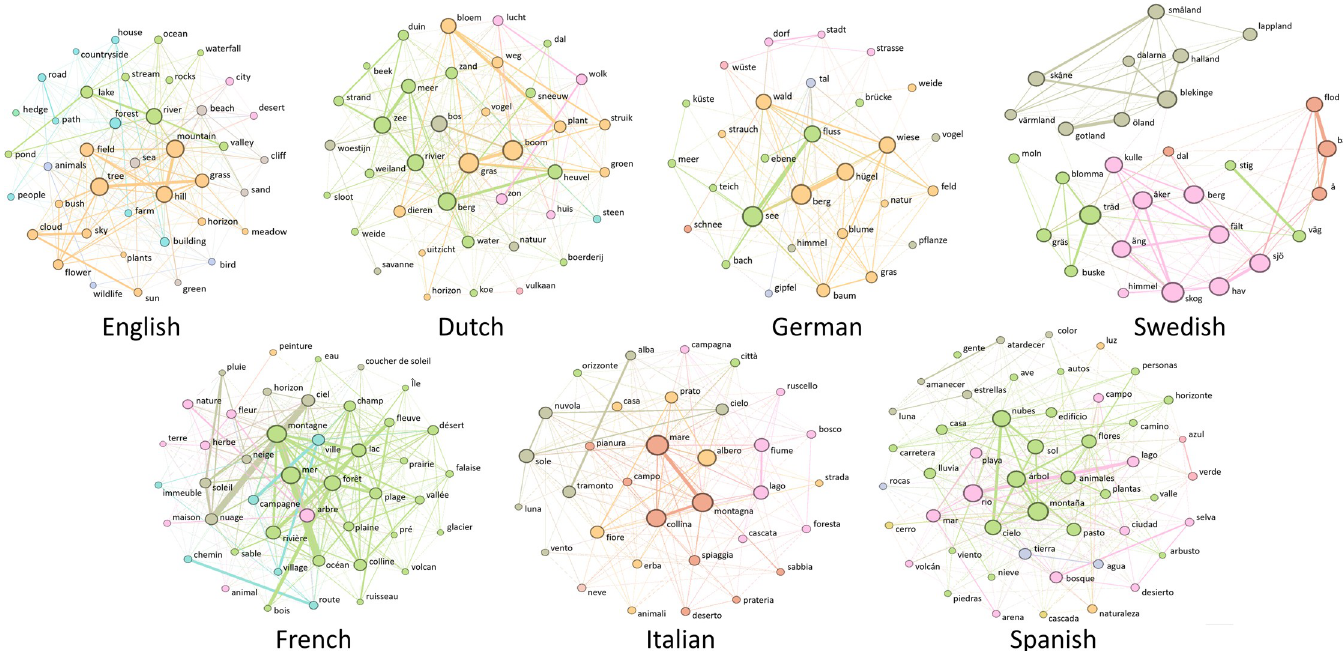
Fig 4. Core landscape concepts across seven languages. Nodes indicate terms, links indicate co-occurrence, and colours indicate clusters within each language.